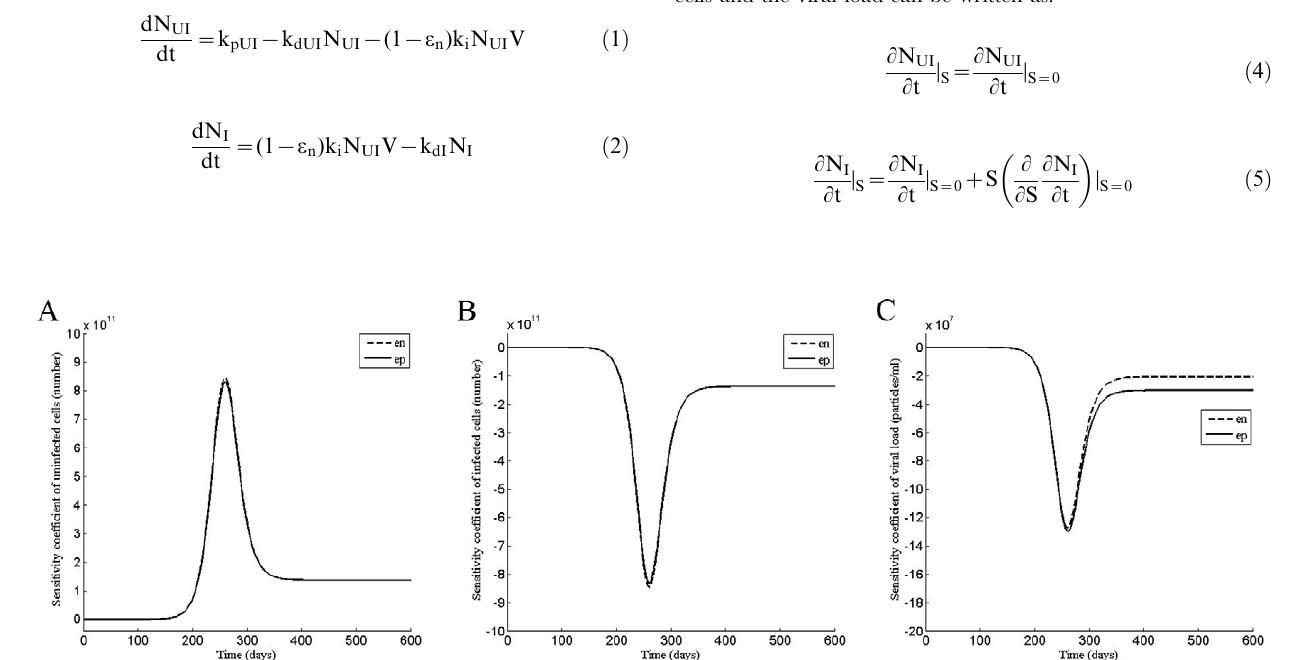
Figure 1. Sensitivity analysis of the model shows different phases of effectiveness of the drug. Sensitivity coefficient of the (A) uninfected cells, (B) infected cells, and (C) the viral load with respect to the efficacies, e n (e n ) and e p (e p ) were plotted as a function of time for e n =0 and e p =0.